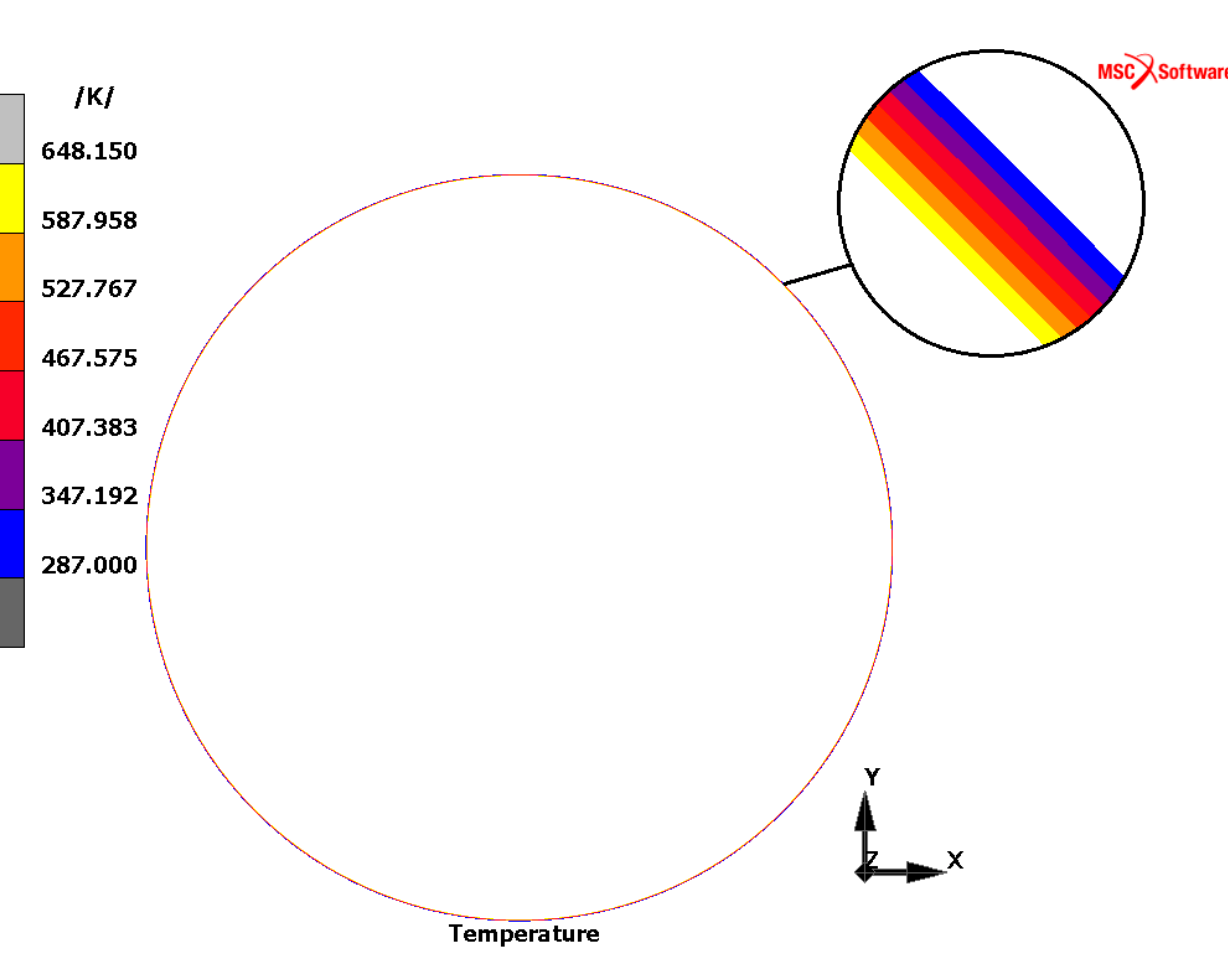
Figure 5. Earthcylinder and its initial temperature distribution T initial.